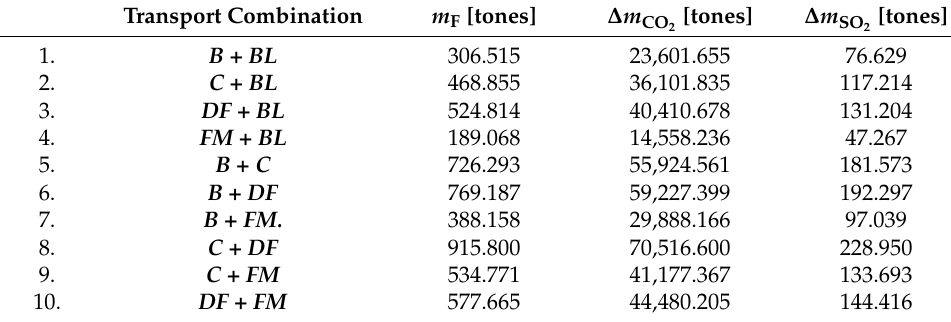
Table 4. Emissions reduction for various combinations of cargo in the event of total transport